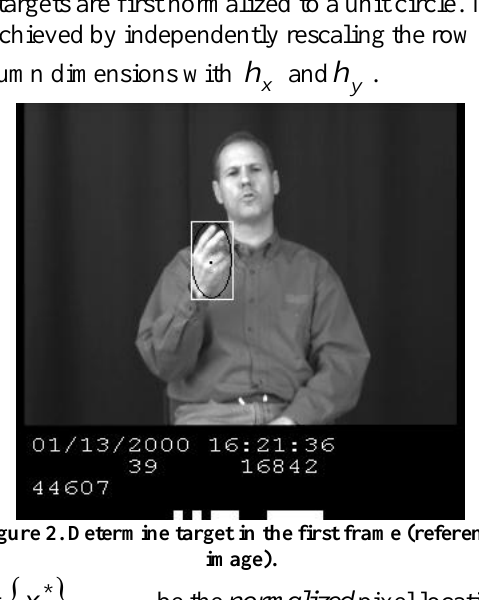
Figure 2. Determine target in the first frame (reference image).